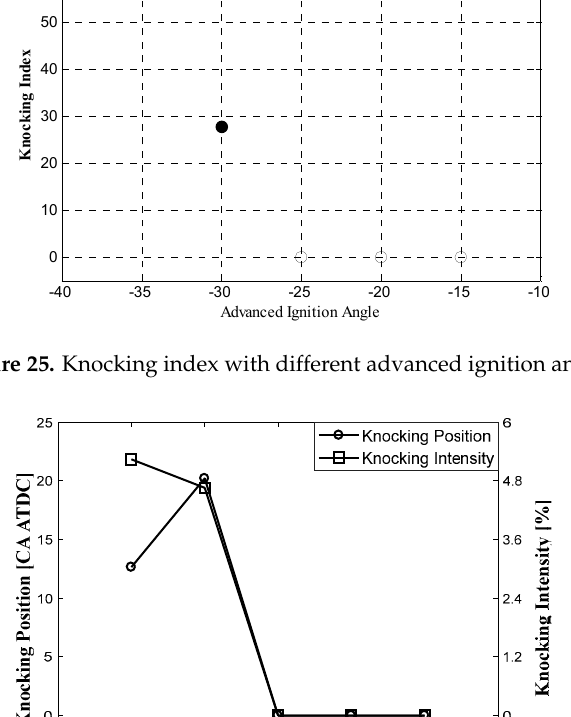
Figure 25. Knocking index with different advanced ignition angle.